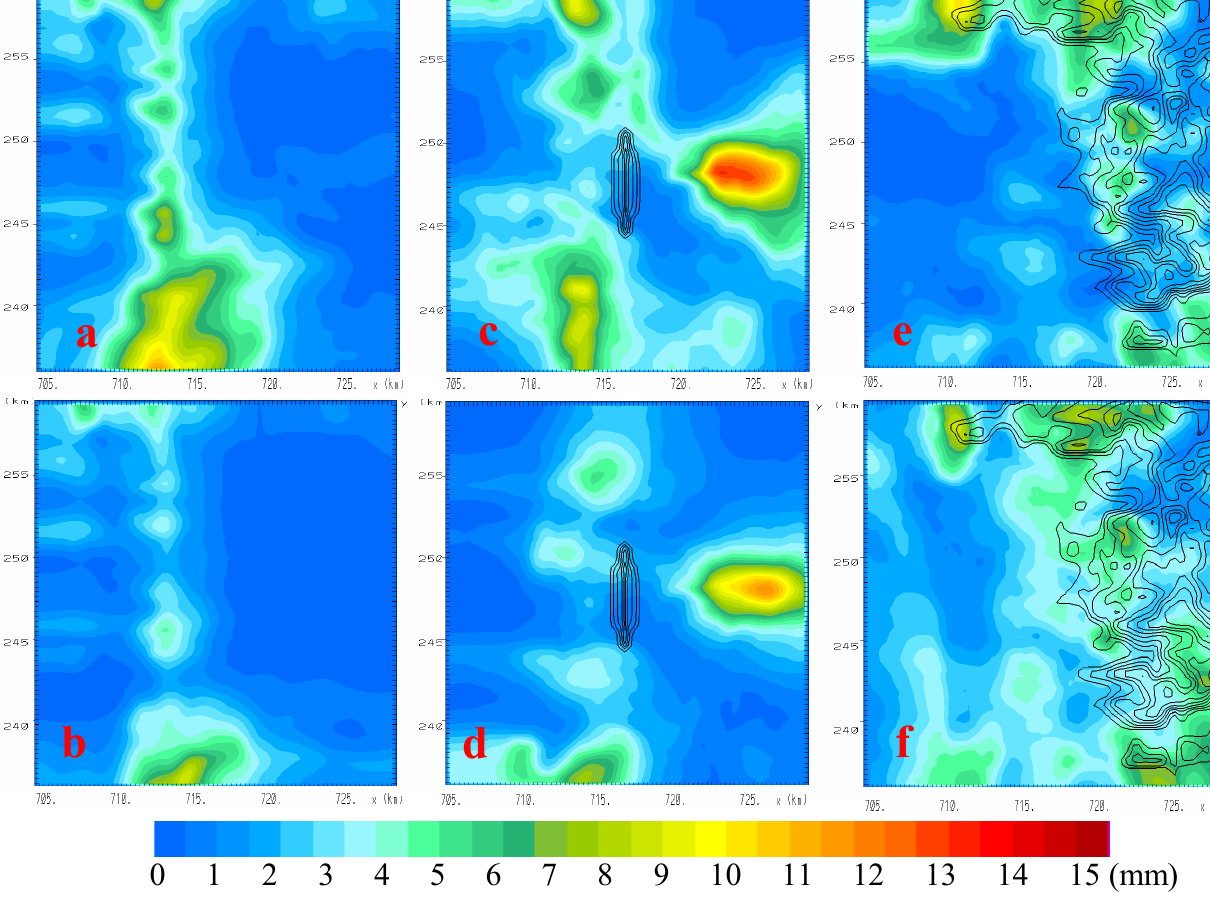
Fig. 5. Four hour accumulated precipitation (colour palette in mm) and 50m topographic line contours. 1st row (a, c, e) : “pristine” aerosol. 2nd row (b, d, f) : “hazy” aerosol. 1st column: No topography (flat terrain). 2nd column: artificial obstacle vertical to the general flow. 3rd column: complex topography. The domain total precipitation for each case is: (a) 12.28m, (b) 7.21m, (c) 16.77m (d) 11.01m, (e) 12.97, (f)